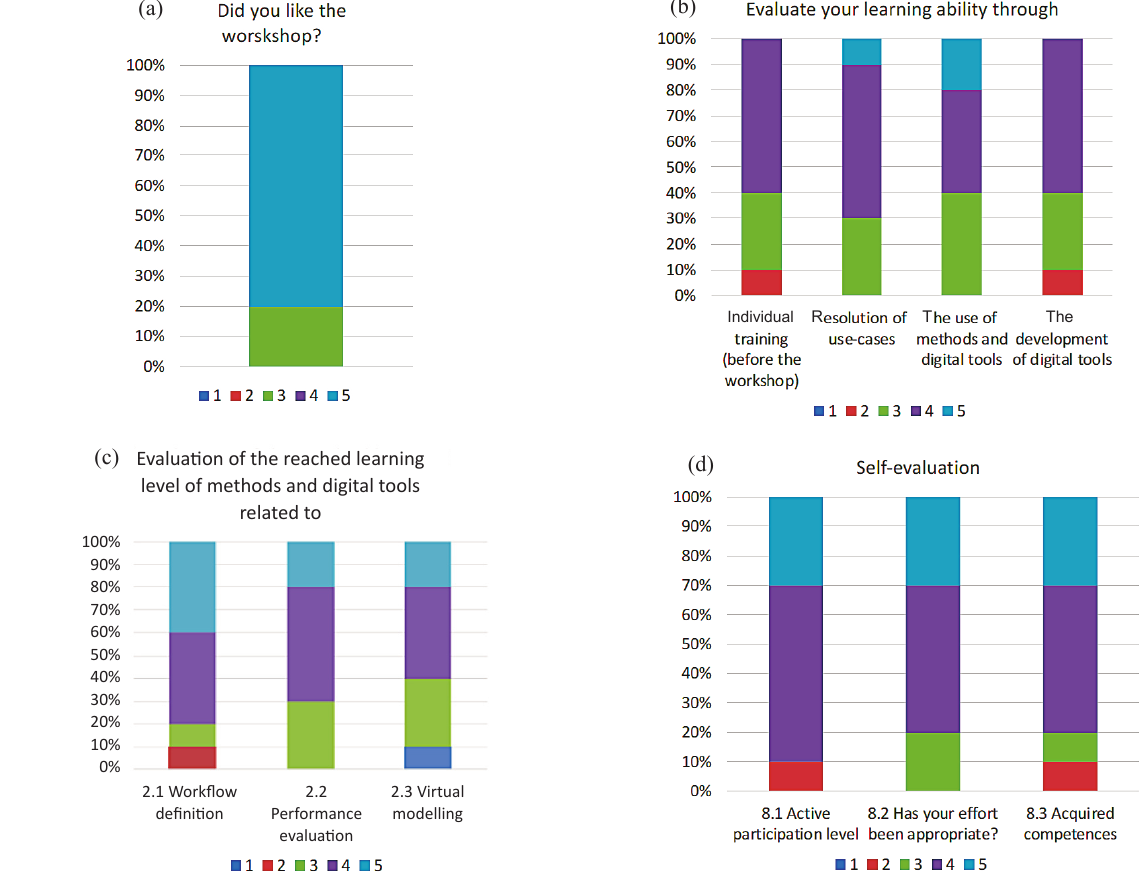
Fig. 9. Graphical representation of students’ feedback about the onsite (1st)